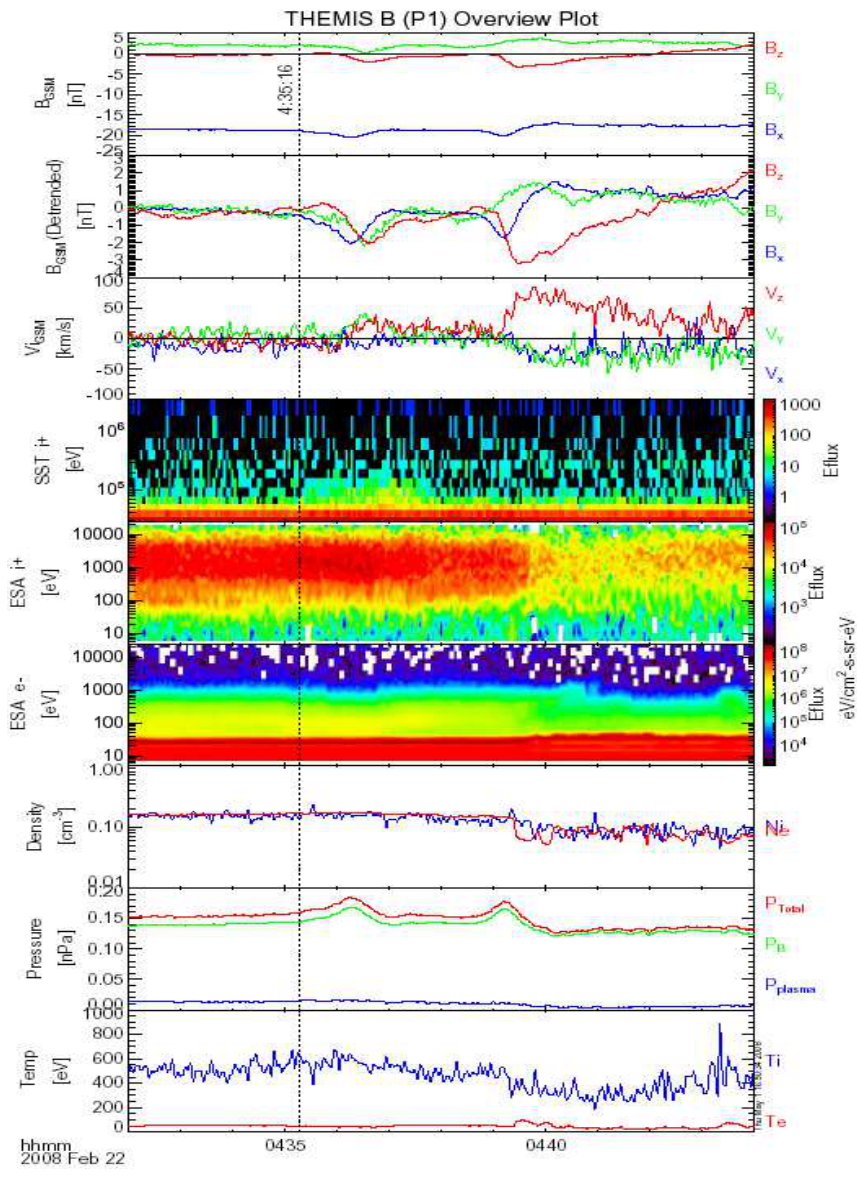
Fig. 4. Observations of THB on 22 February 2008 around